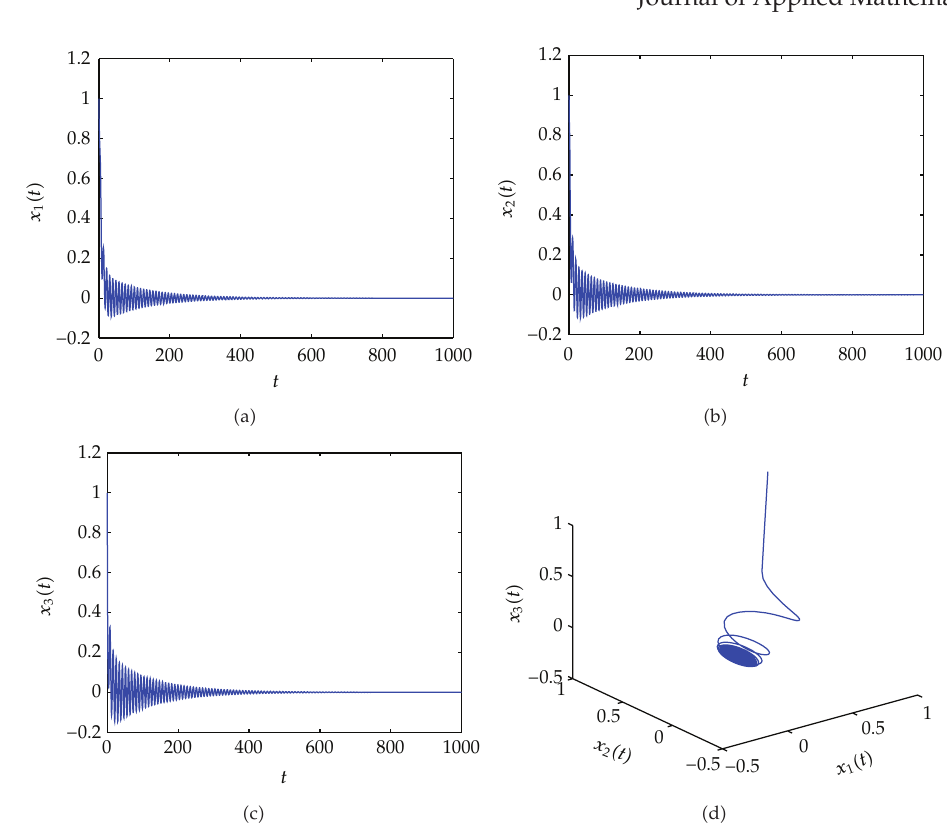
Figure 2: When τ (cid:7) 1.7 < τ 0 (cid:7) 1.8434, the zero equilibrium is asymptotically stable. Here initial value is (cid:5) 1, 1, 1 (cid:6)